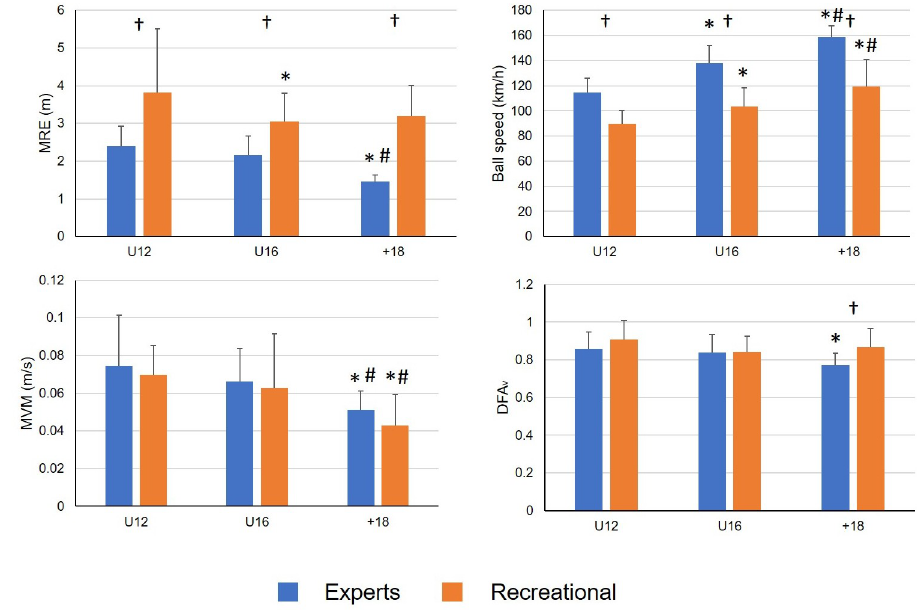
Fig 2. Pair comparisons between age ranges and expertise